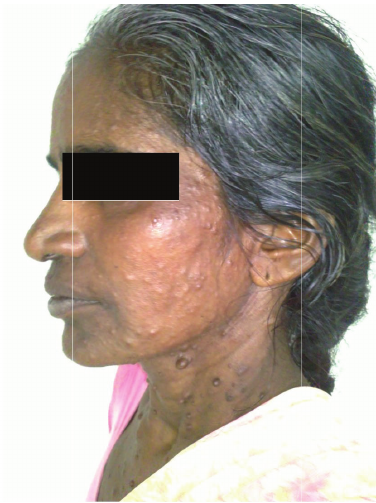
Figure 1: Diffuse multiple brownish black pigmented nodular masses of various sizes spread all over the body.